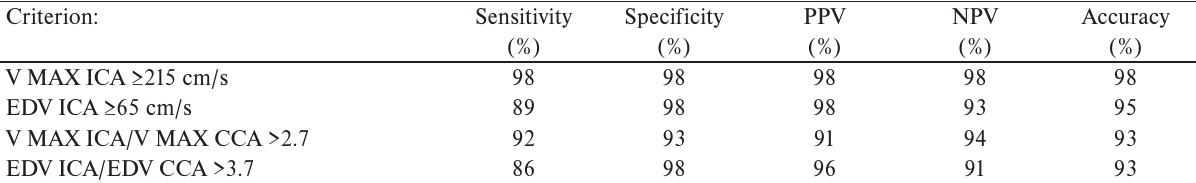
Table 1. Suggested velocity criteria for determination of ≥70% stenosis.